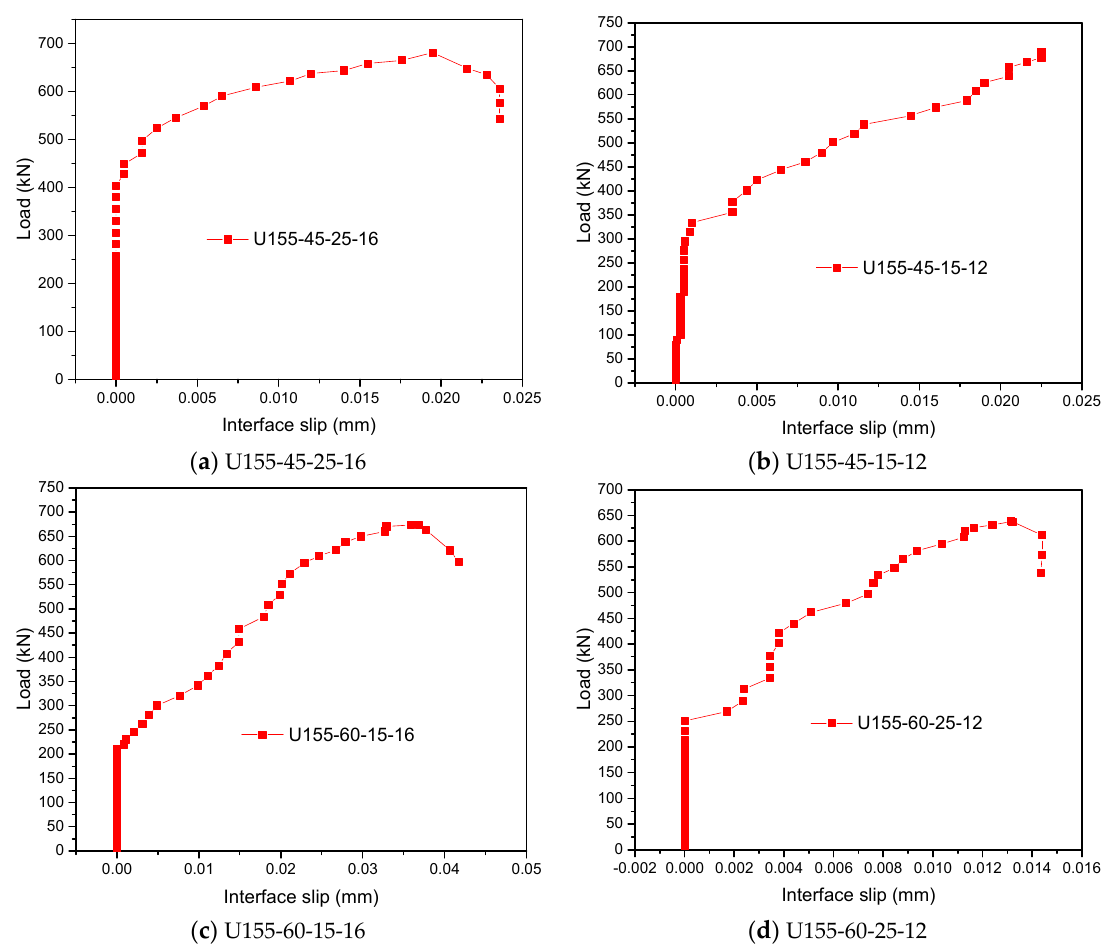
Figure 13. Load-interface slip curves of some members.